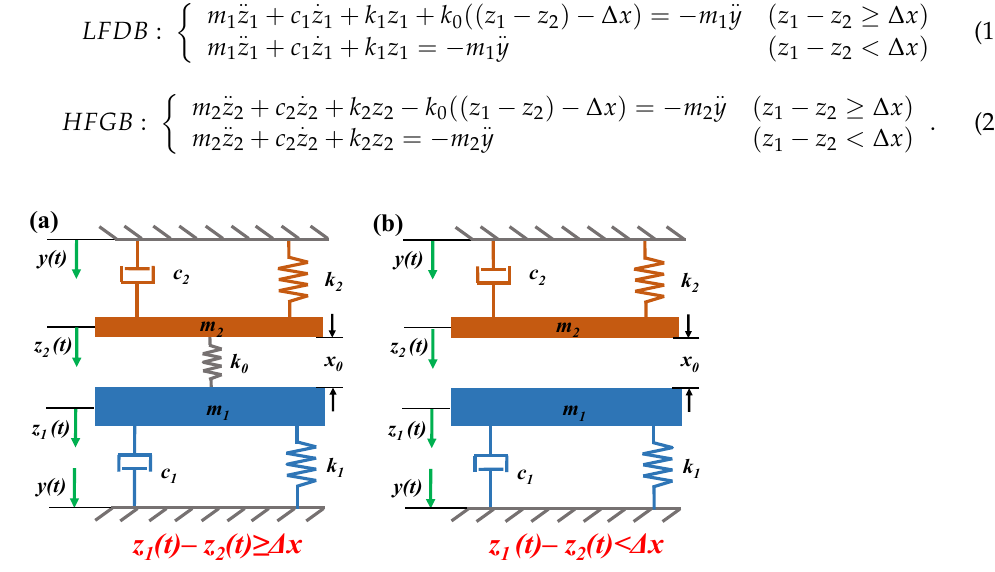
Figure 3. Mechanical model of the proposed PVEH as ( a ) z 1 − z 2 ≥ Δ x and ( b ) z 1 − z 2 < Δ x .